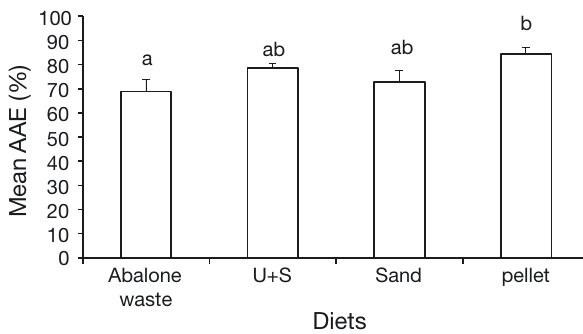
Fig. 6. Mean (+SE) apparent assimilation efficiency (AAE) of Neo stichopus grammatus fed 4 experimental diets (n = 32). Different letters above each bar indicate a significant difference between treatments (Tukey, p < 0.05). U+S: Ulva